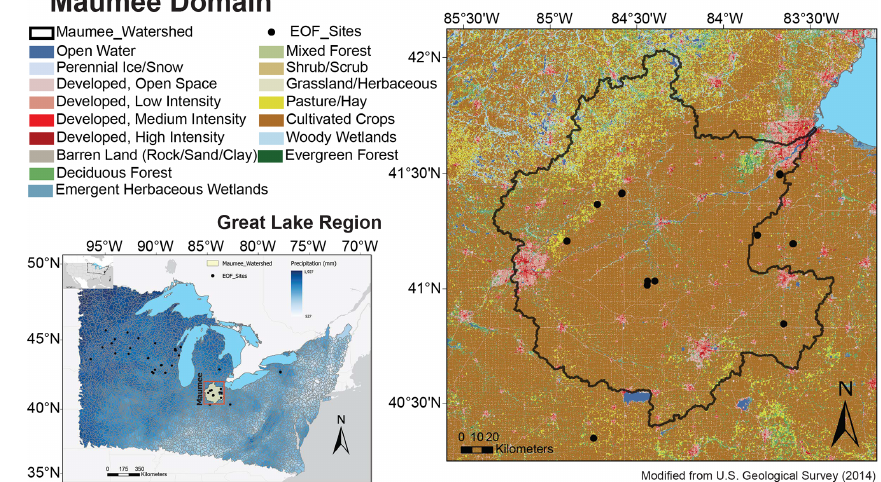
Figure 2. Study area of the Maumee domain in the Great Lakes region, USA. EOF sites (black dots) denote the locations where the observa- tional data of daily edge-of-field (EOF) runoff is available over multiple